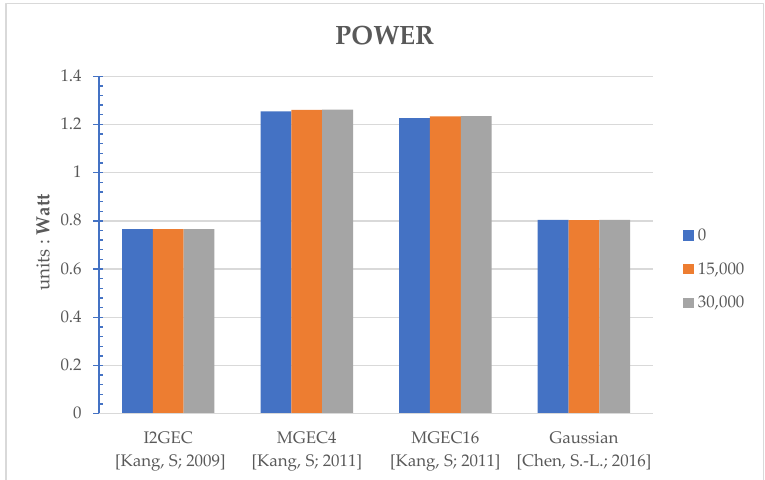
Figure 5. Bar comparisons of power (watts) of different algorithms at different thresholds.